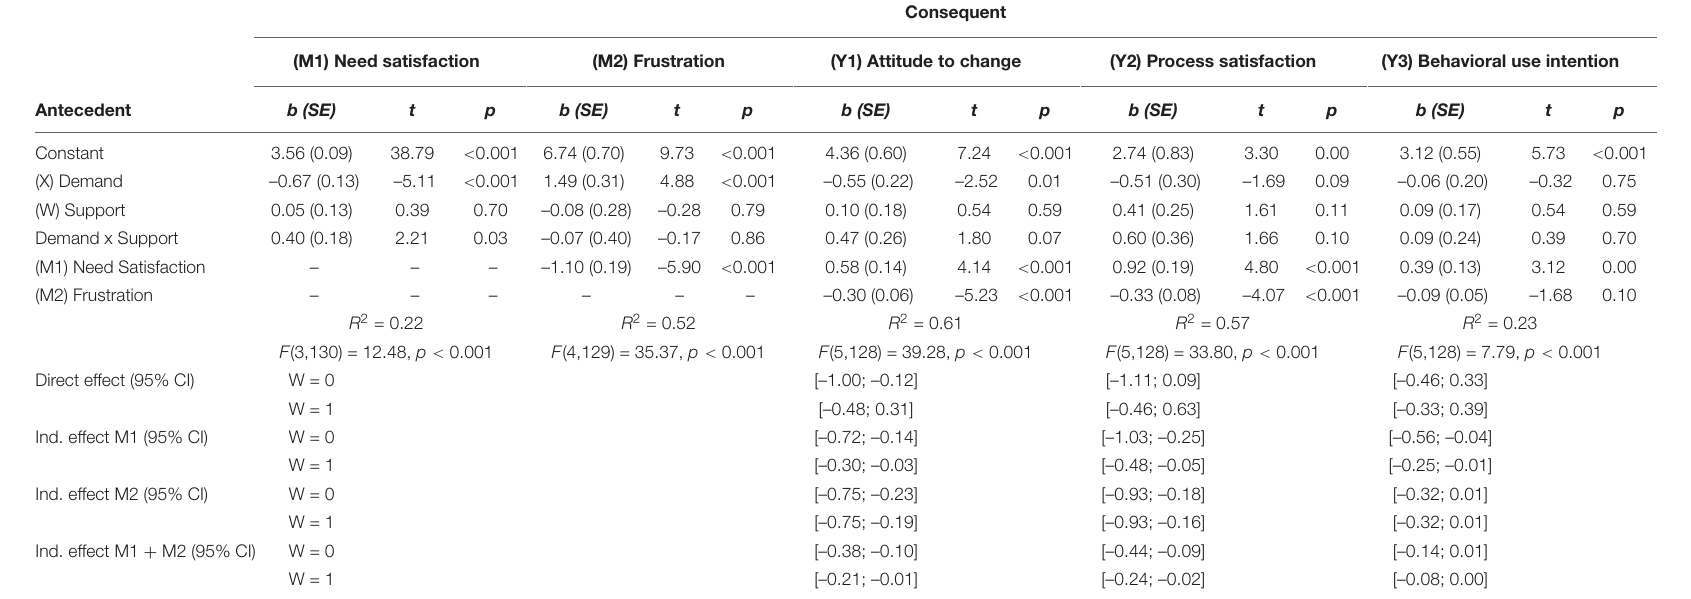
TABLE 6 | Regression coefficients, standard errors, and model summary information of the moderated mediation model – Study